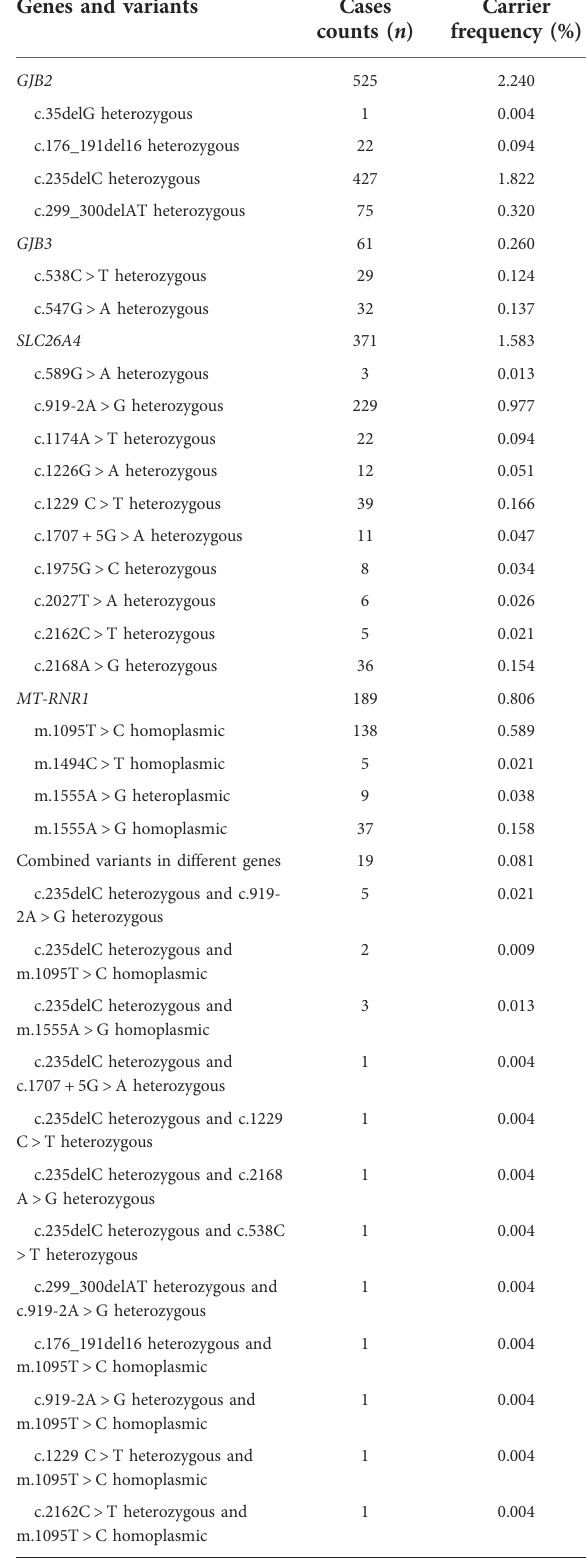
TABLE 3 Hearing screening results of 24,349 newborns in our study. Results of audiological screening